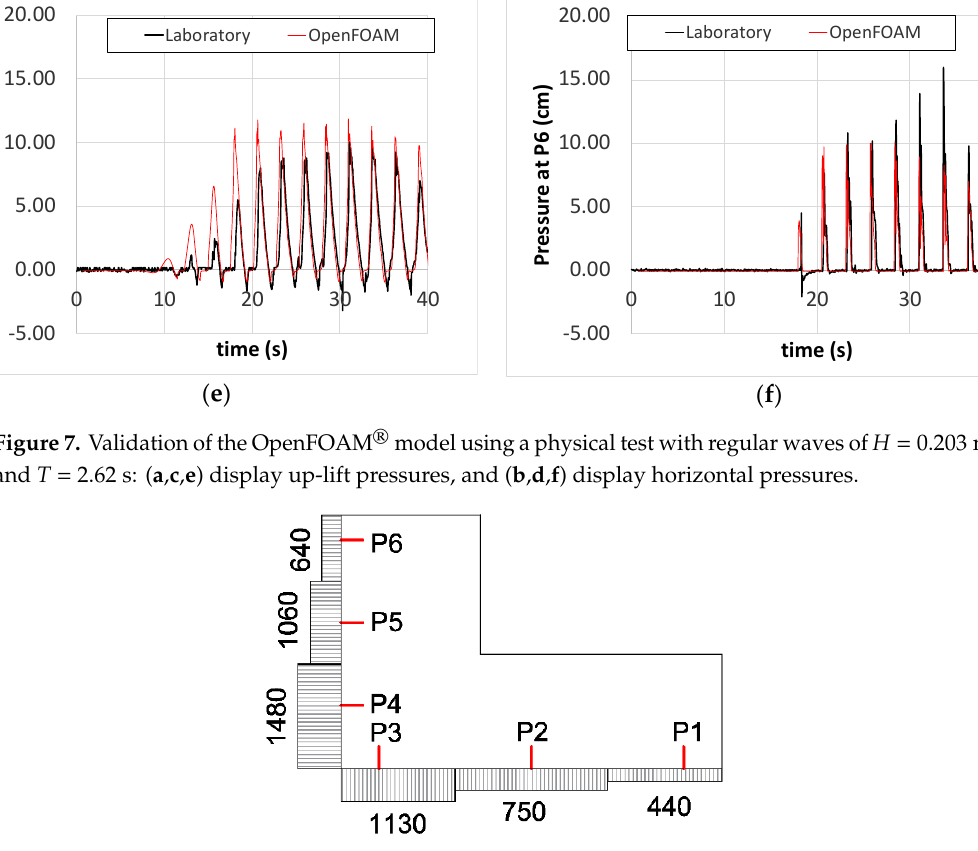
Figure 8. Peak pressure distribution of the physical test with regular waves of H = 0.203 m and T = 2.62 s in t = 25.15 s. Units presented in Pascals.